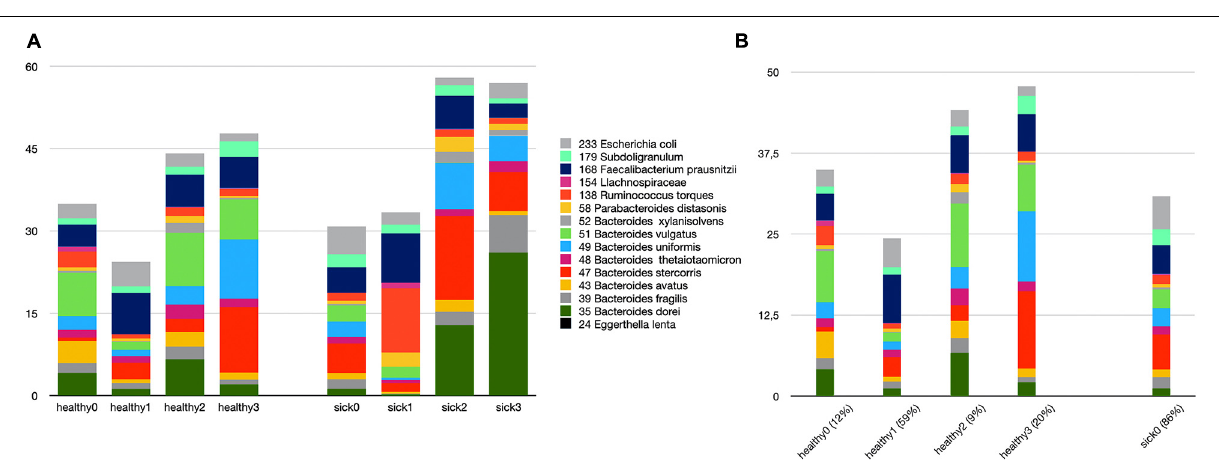
FIGURE 5 | The relative amounts of 15 species (A) in all healthy and T2D subgroups. (B) Zoomed-in view of all healthy subgroups and one T2D subgroup, which covers more than 86% of all